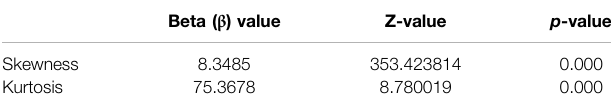
TABLE 3 | Multivariate skewness and